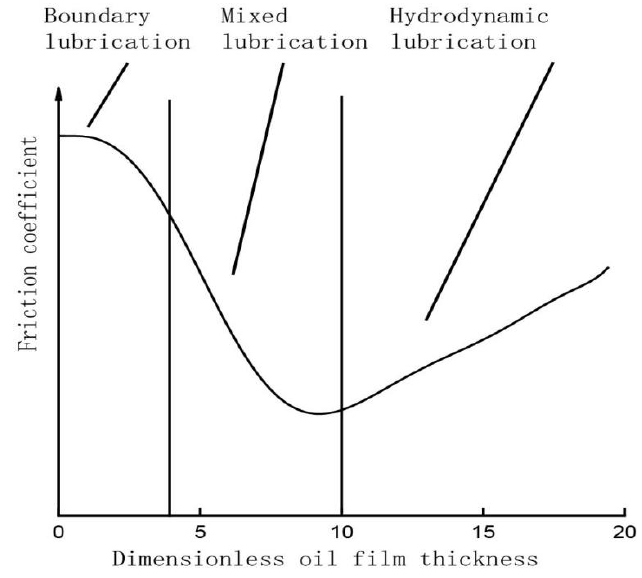
Figure 1. Stribeck curve.